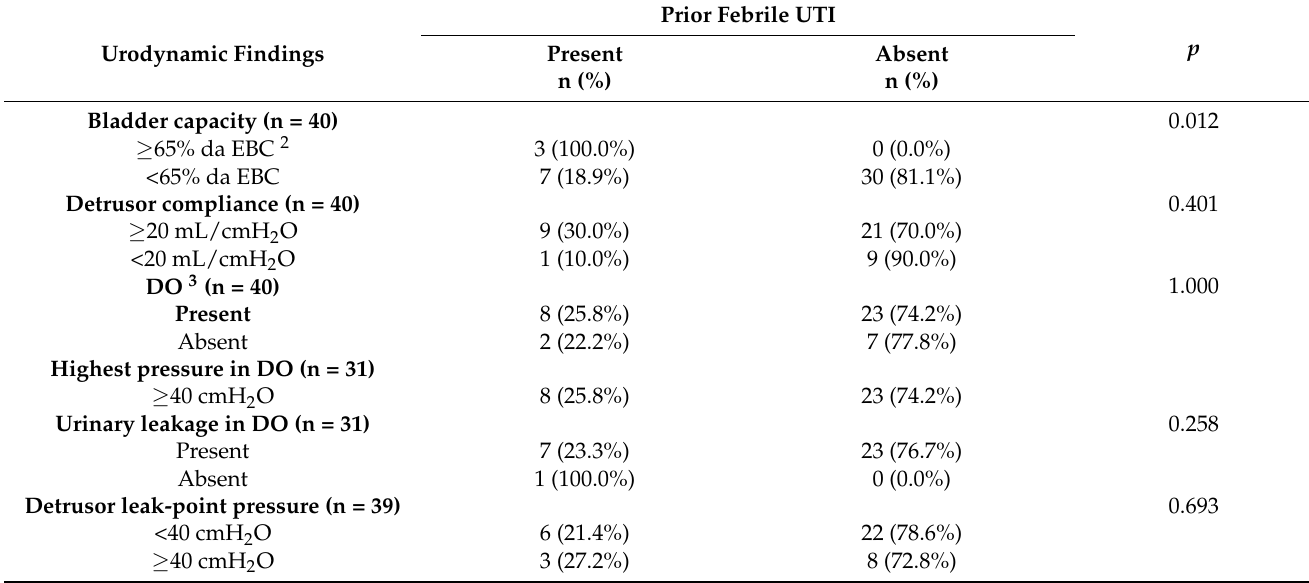
Table 3. Association between urodynamic findings and prior febrile UTI 1 in 40 children who underwent UDS at the OCUH-UPE from October 2018 to March 2020 as part of the